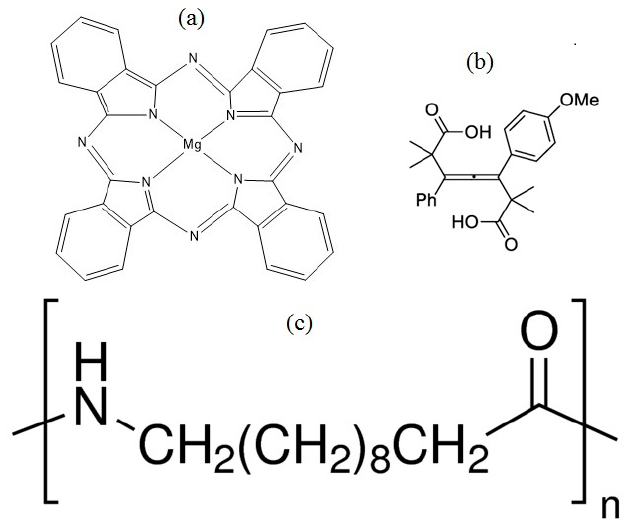
Figure 1. Structure of ( a ) MgPc, ( b ) tetrasubstituted allene, and ( c ) Nylon